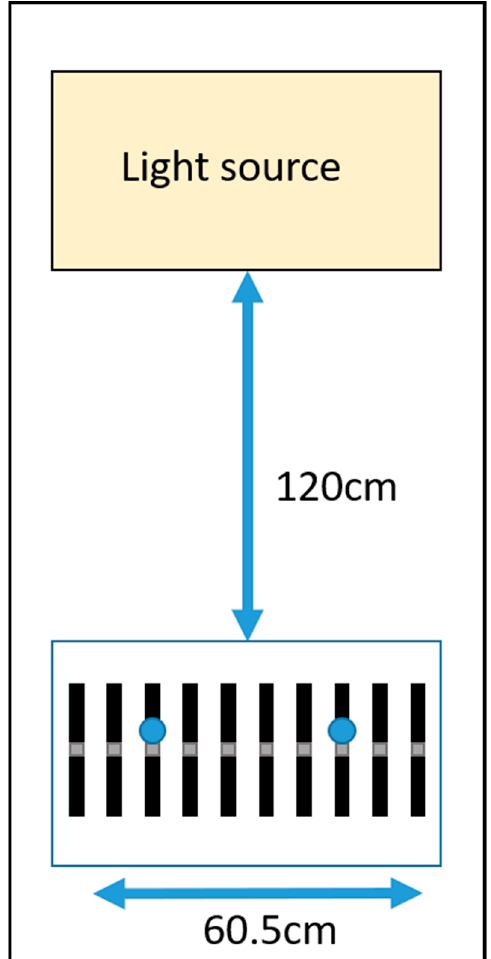
Figure 1. Diagram of device testing configuration. Devices ( n = 10) were evenly distributed along a white 56 × 60.5 cm board, with sensors facing upwards towards the light source. The board was 120 cm directly beneath the main light source (or centred between light sources in the case of the spectral performance assessment). Lux meter readings were taken at two points along the devices, marked by blue circles. An infrared camera was located on the ceiling next to the light source. Walls surrounding the board and light source were covered in matte black material. The device configuration on the board was identical for the outdoor light test.